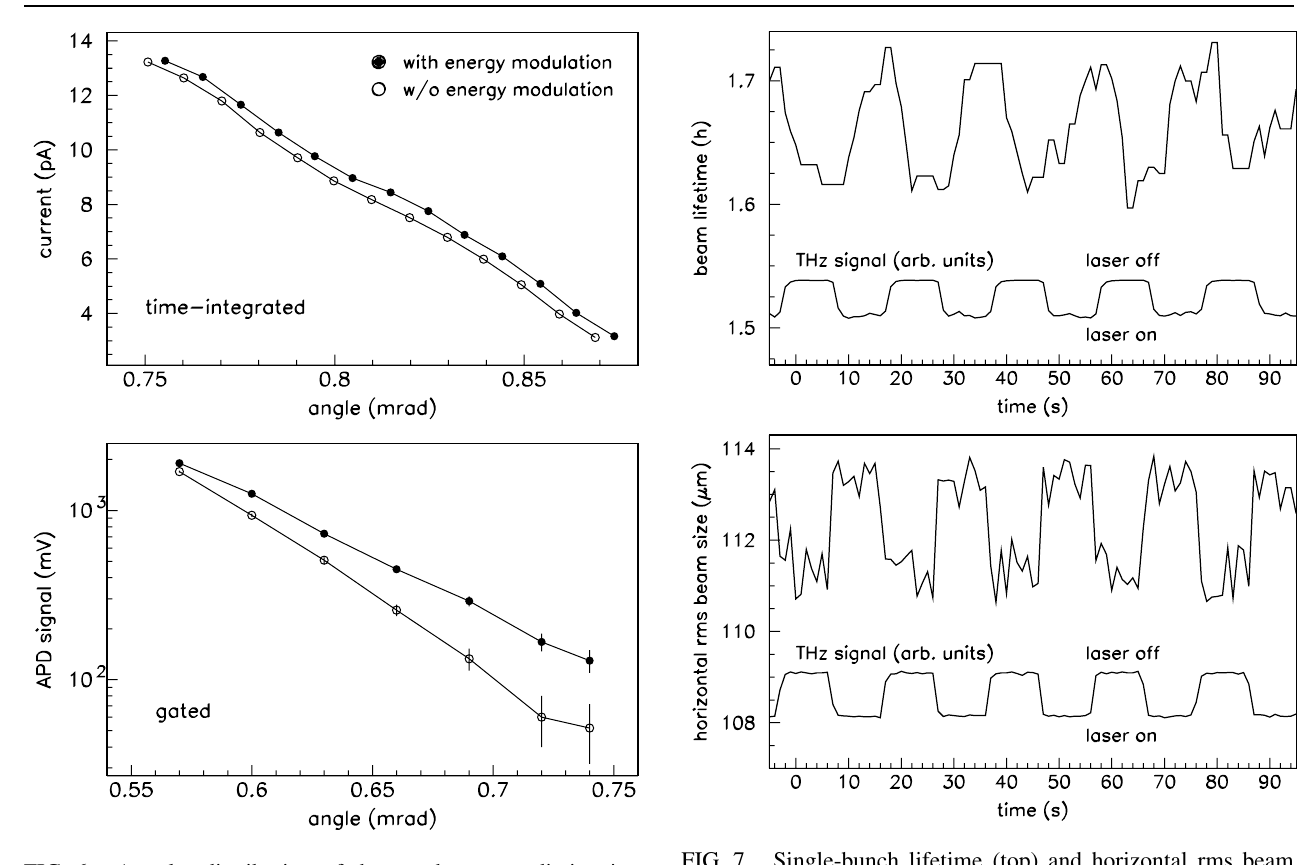
signal.FIG. 6. Angular distribution of the synchrotron radiation in- tensity at 708 eV from a time-integrated measurement using a GaAs diode (top) and from an avalanche photodiode (APD) gated synchronously with the laser pulse